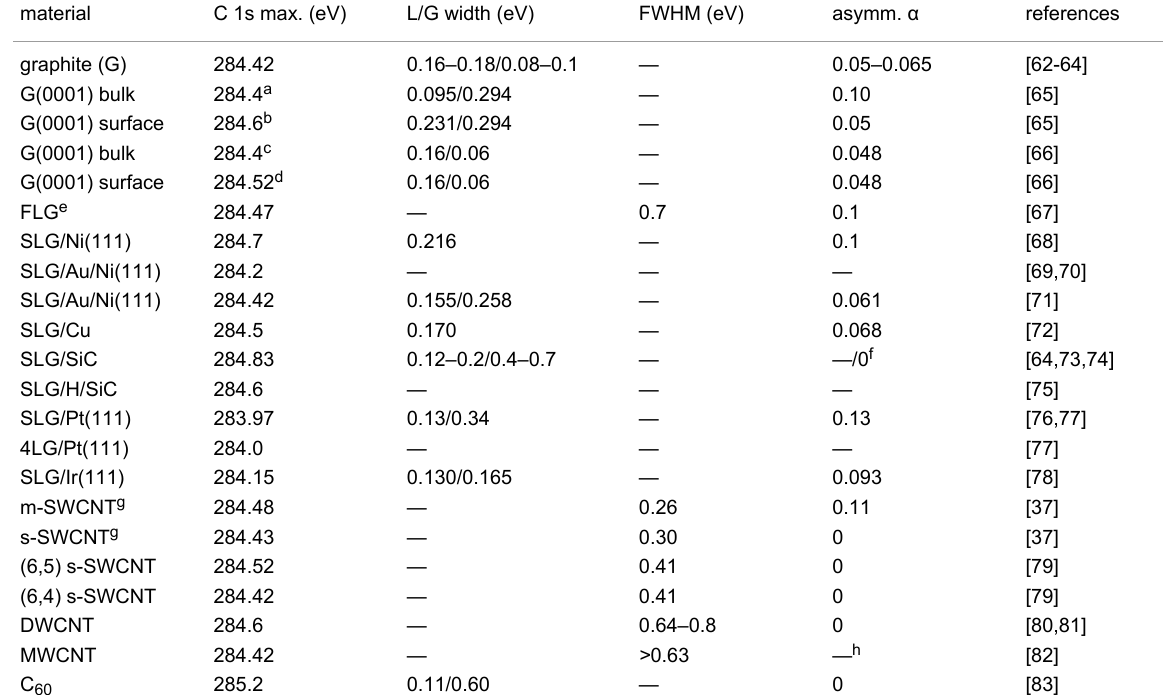
Table 1: Photoemission measurements of the carbon 1s line for various graphitic carbon nanomaterials reported in the literature. The columns show the material, position of the maximum of the carbon 1s response, the energy width of the Lorentzian/Gaussian component, or, the full width at half maximum if these contributions have not been separated, the asymmetry index α , and the literature citation for each measurement.